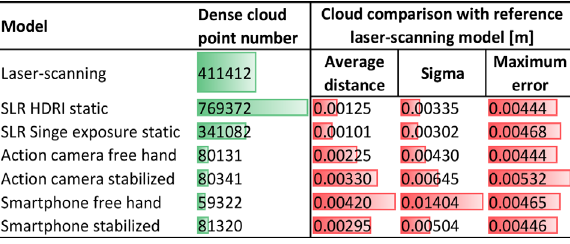
Figure 11. Comparison of the accuracy of 3D laser scanning data and photogrammetric models